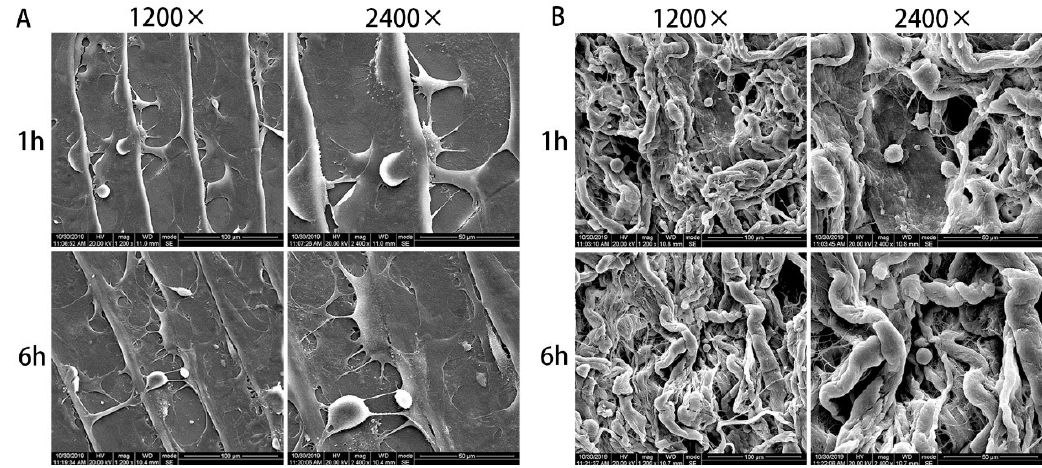
Figure 5. Cell adhesion of BMSCs on the FS ( A ) and BG ( B ).